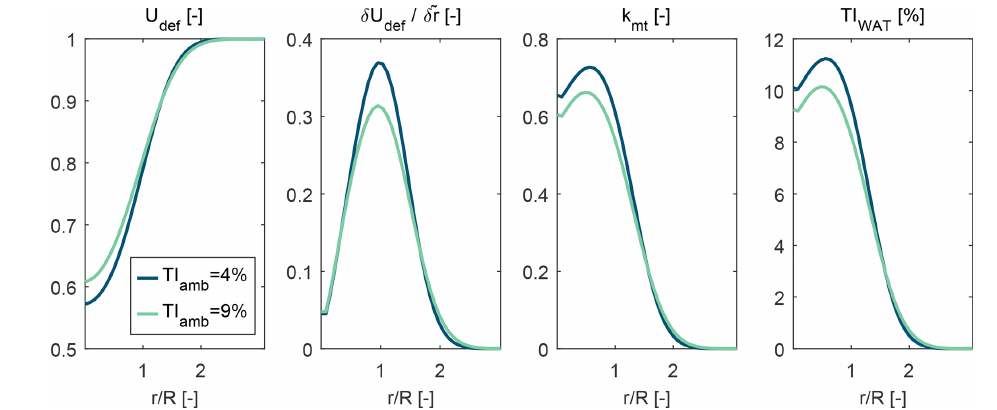
Figure 1. Exemplary results from the calculation of wake-added turbulence from left to right: velocity deficit distribution, radial gradient of the velocity deficit, scaling factor k mt , and resulting distribution of the turbulence intensity from the wake-added turbulence TI WAT . Calculations are made for two ambient turbulence levels at 6D behind the rotor. Simulations are performed with FAST.Farm in neutral atmospheric conditions with a mean wind speed of 6.5ms − 1 at hub height.